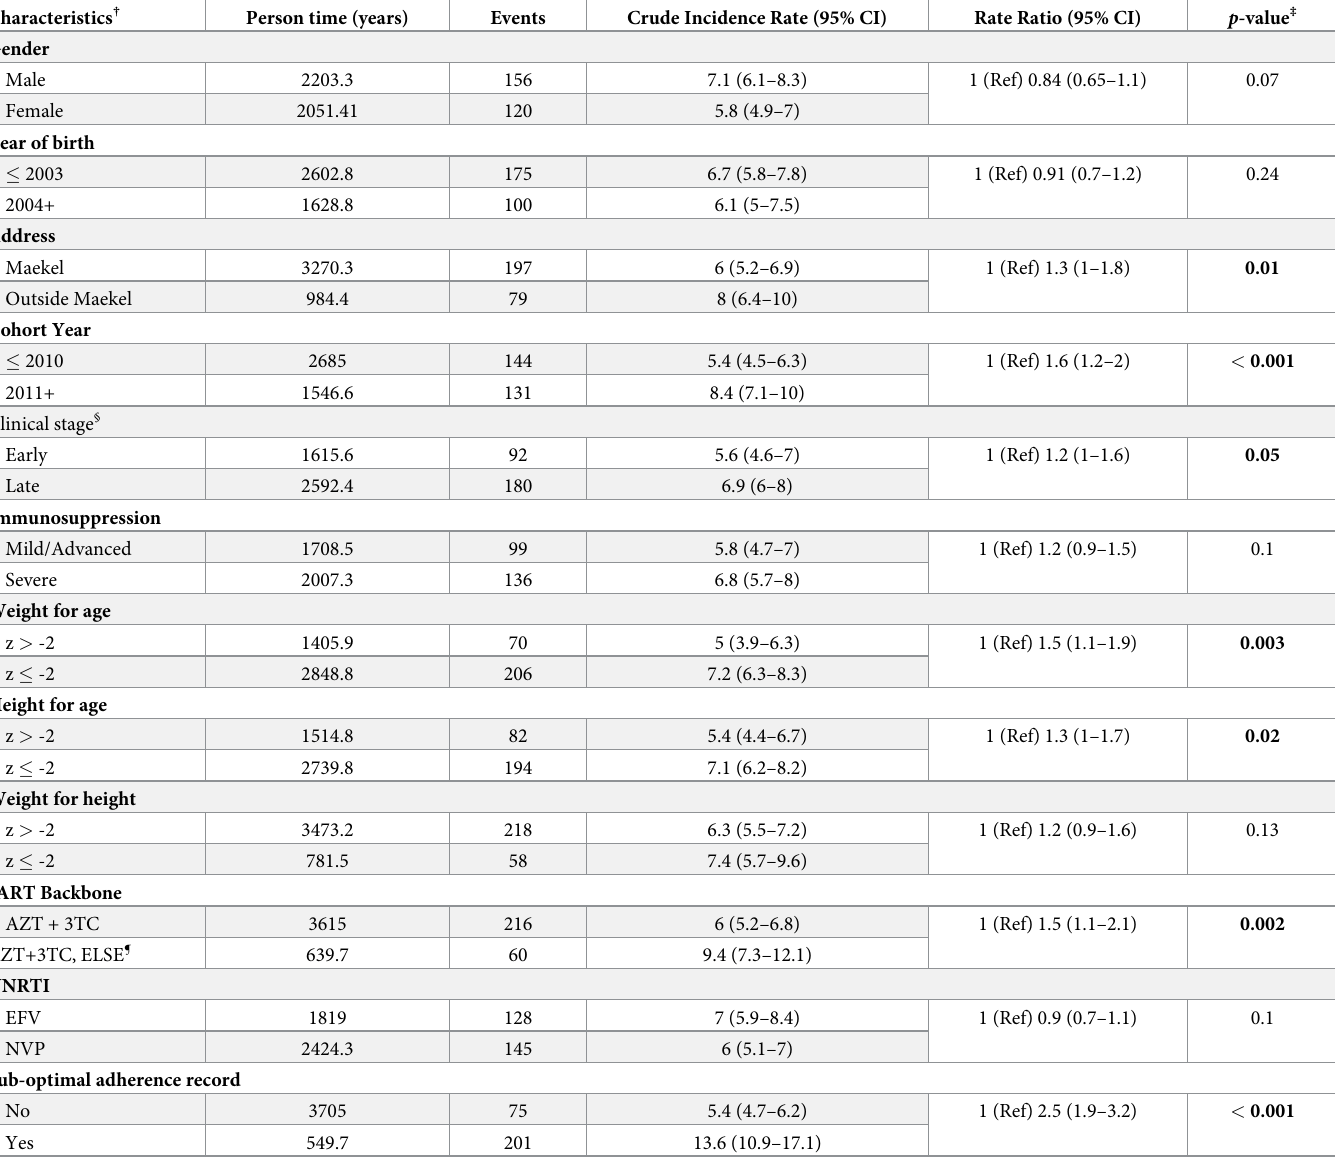
Table 2. Crude incidence and associated factors of therapy failure among children and adolescents in National Referral Pediatric Follow-up Clinic, Asmara, Eritrea (2005–2020). Characteristics